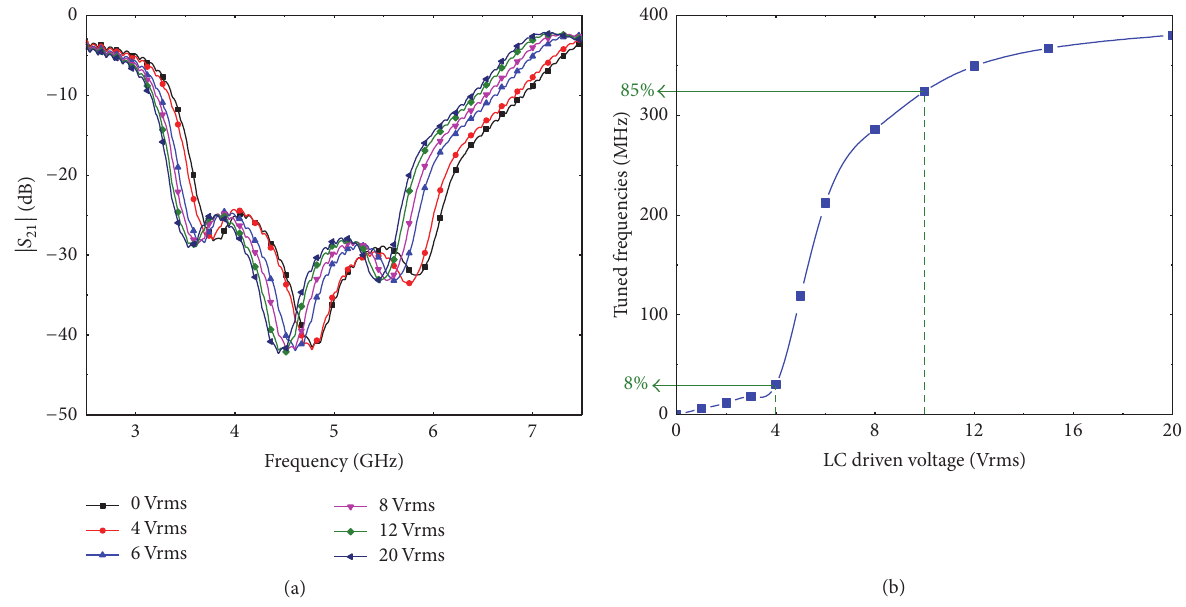
Figure 9: Measured results of (a) transmission |𝑆 21 | and (b) tuned frequencies with respect to LC driven voltage.